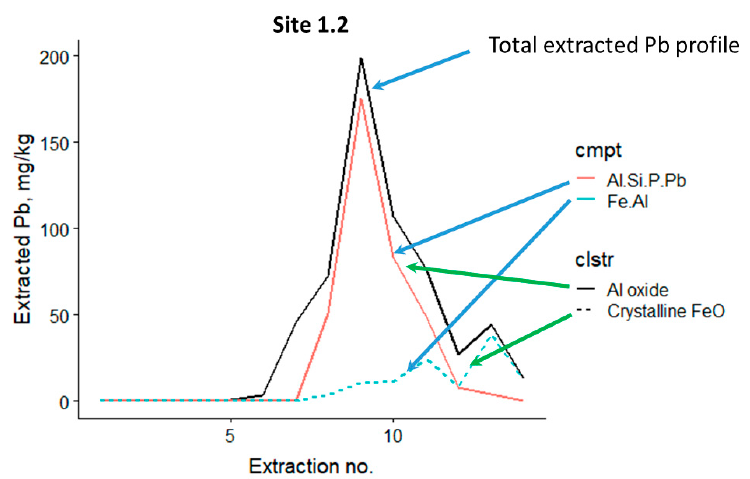
Figure 10. Example plot of the underlying contributions to the total extracted Pb profile (solid black line). The two main contributing components (cmpt) are indicated by colour for this specific soil (red